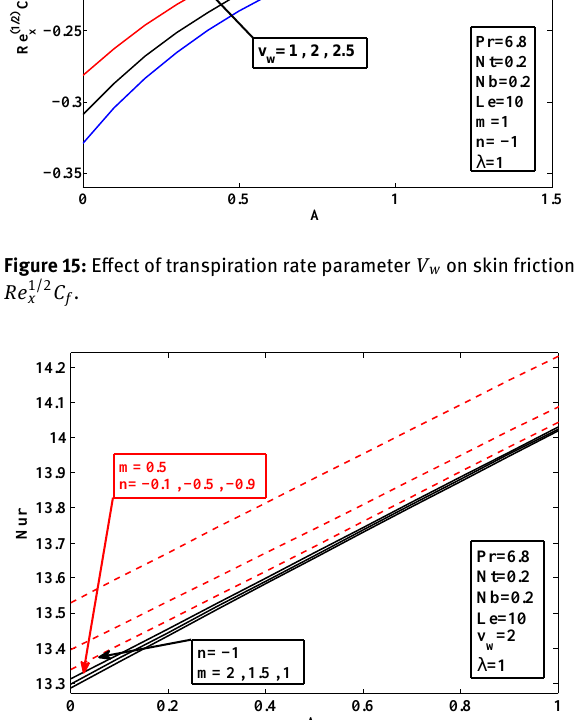
Table 2: The smallest eigenvalues γ for various values of λ ,